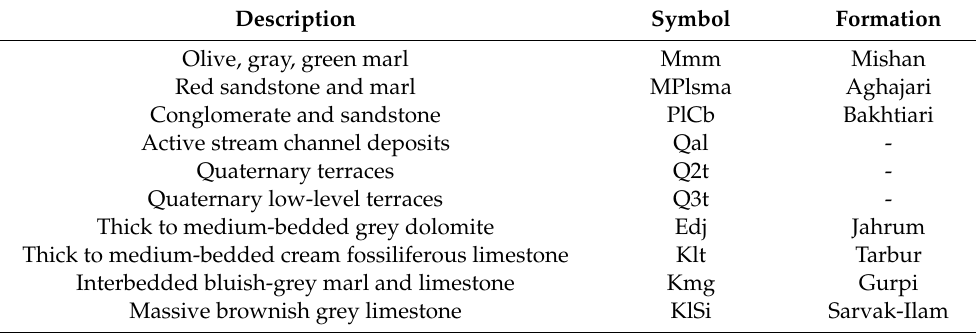
Table 1. Geological units in the study area